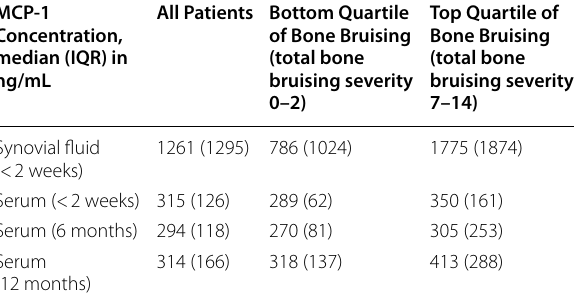
Table 2 MCP-1 (monocyte chemoattractant protein 1) levels in knee synovial fluid and serum at three time points post-ACL rupture by severity of bone bruising on MRI. Values are median (IQR) in ng/mL MCP-1 All Patients Bottom Quartile Concentration, of Bone Bruising median (IQR) in ng/mL Synovial fluid (< 2